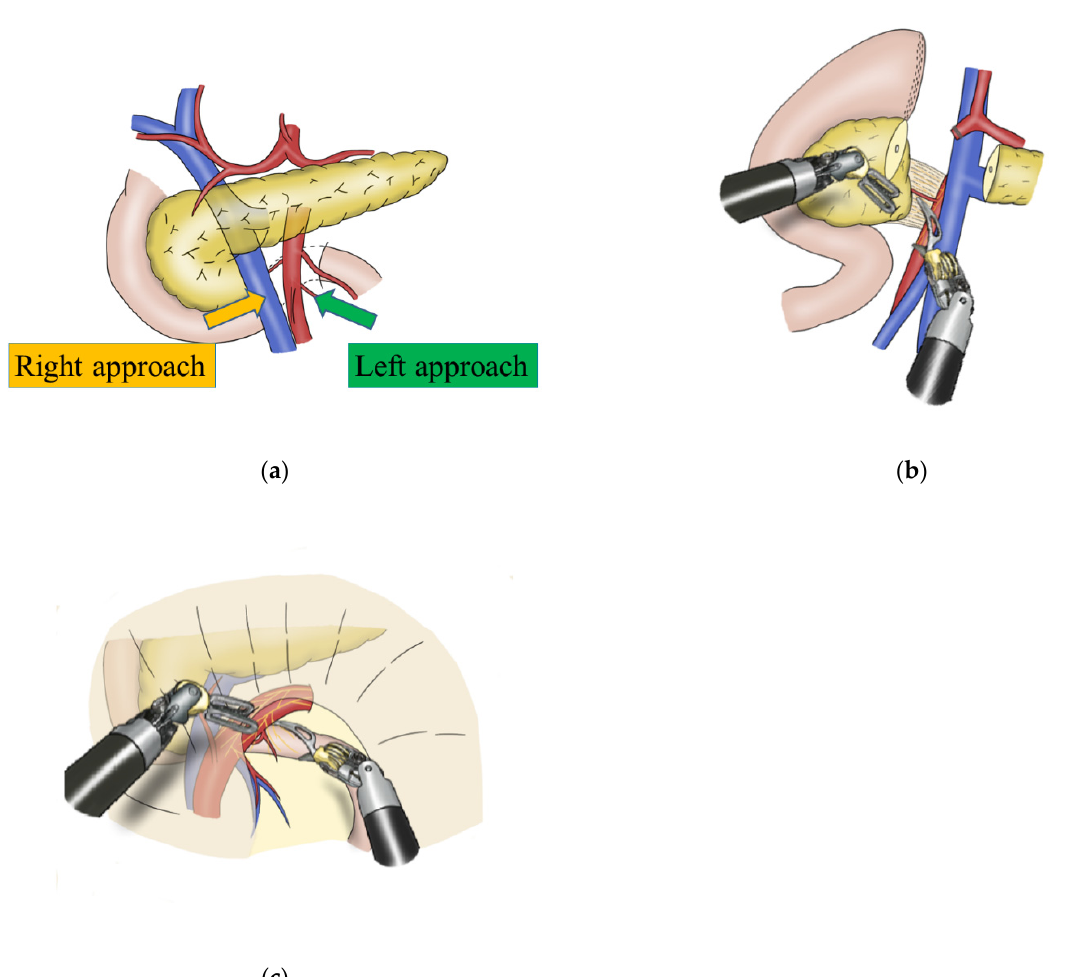
Figure 1. Surgical approaches to the superior mesenteric artery (SMA) in robotic pancreatoduode- nectomy: ( a ) right and left approaches to the SMA; ( b ) right approach to the SMA; ( c ) left approach to the SMA.